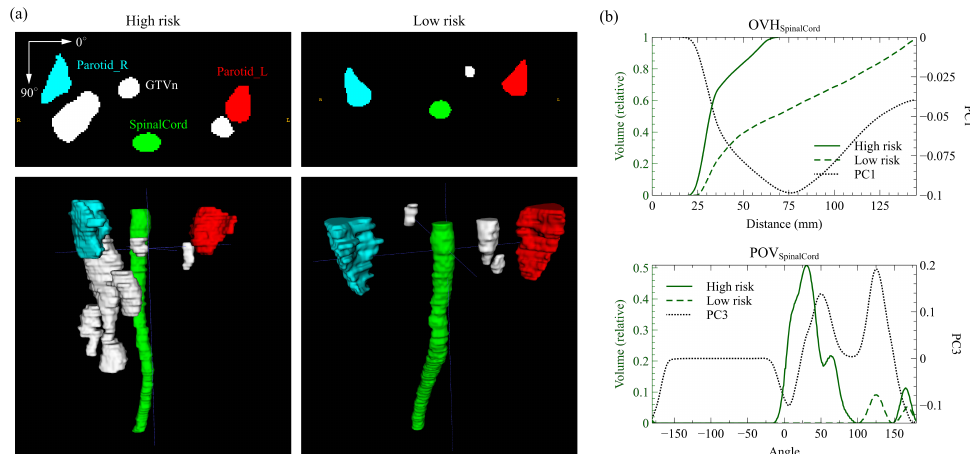
Figure 4. Quantitative anatomical characterizations of the high-risk and low-risk patient. ( a ) The axial slice masks and rendered 3D volumes of GTVn (lymph node tumor), Parotid_L, Parotid_R, and SpinalCord structures. ( b ) The SpinalCord overlap volume histogram (POV) and projection overlap volume (POV) of the two patients and the corresponding selected principal component (PC) vector. Significant differences in lymph node anatomy were captured by the large variations in the histograms and highlighted by the